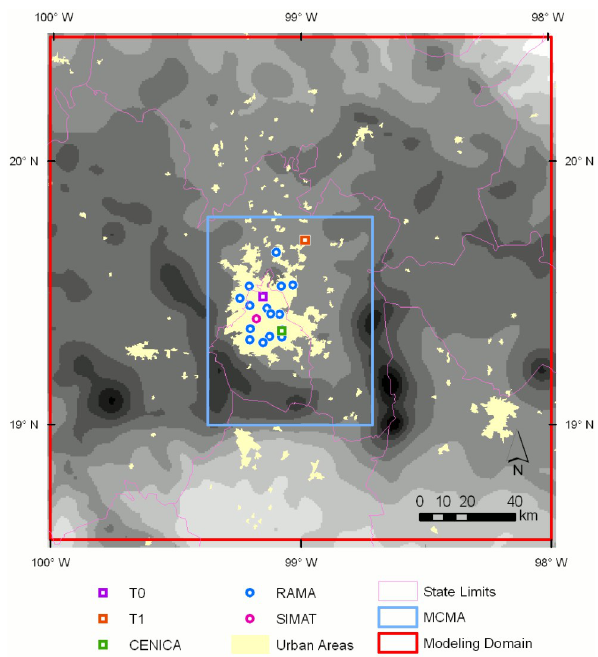
Fig. 1. Air quality modeling domain (3 km by 3 km; the outer red square) with RAMA monitoring sites (blue), CENICA site (green), T0 supersite (purple), and T1 supersite (orange) from the MCMA-2006 field campaign. Light blue domain indicates the area covered by 2006 official emission inventory for MCMA, 2006 EI. Light yellow shading denotes urban areas. Topography contour intervals are 400 meter, and the pink contour represents the political state limits.